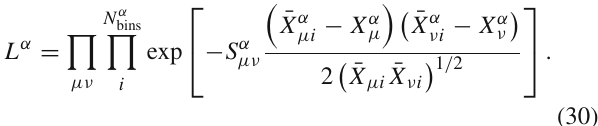
Fig. 1 DifferencebetweenthecombinedvaluesusingadirectPoisson- likelihoodcombinationandthemethodproposedherewithNeymanand Pearson χ 2 definition relative to the total uncertainty. The estimates to be combined differ by about γσ and are displayed as a function of the first estimate’s relative statistical uncertainty. The second estimate’s statistical uncertainty scales accordingly combined either using a Pearson or Neyman χ 2 definition.